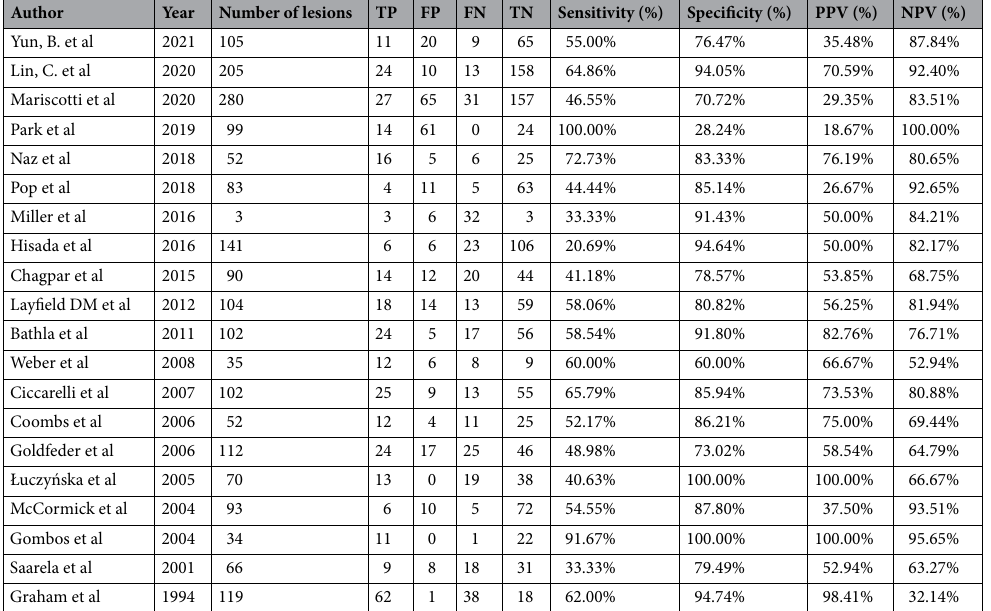
Table 2. Included studies containing raw diagnostic accuracy data for meta-analysis. TP true positive; FP false positive; FN false negative; TN true negative; PPV positive predictive value; NPV negative predictive